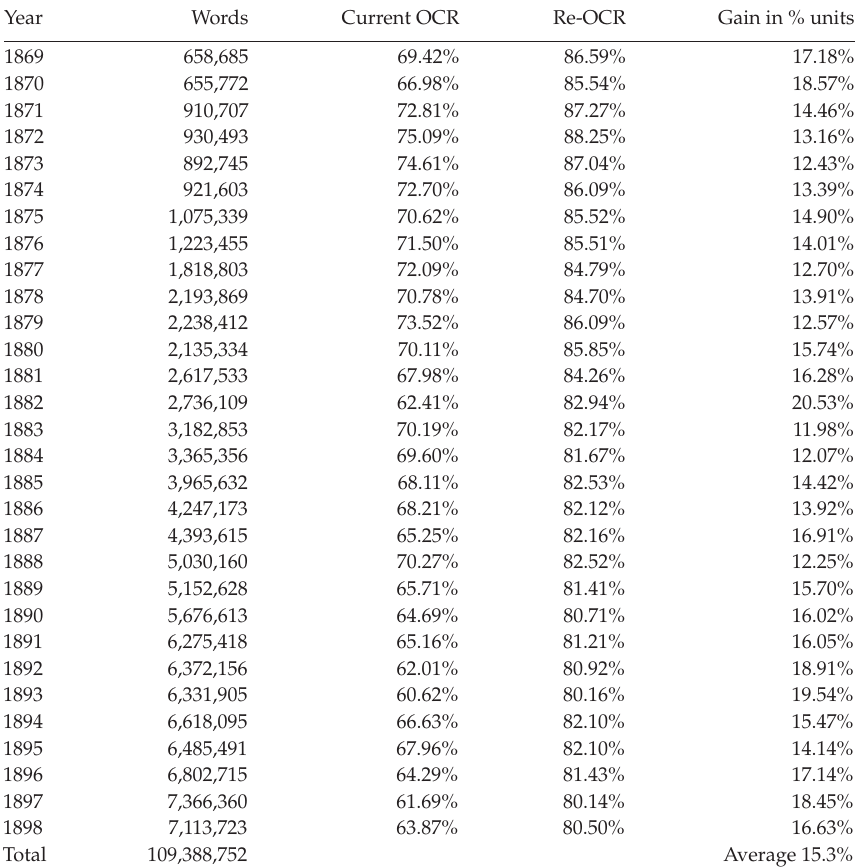
Table 7: Recognition rates of current and new OCR words of Uusi Suometar with morphological analyzer